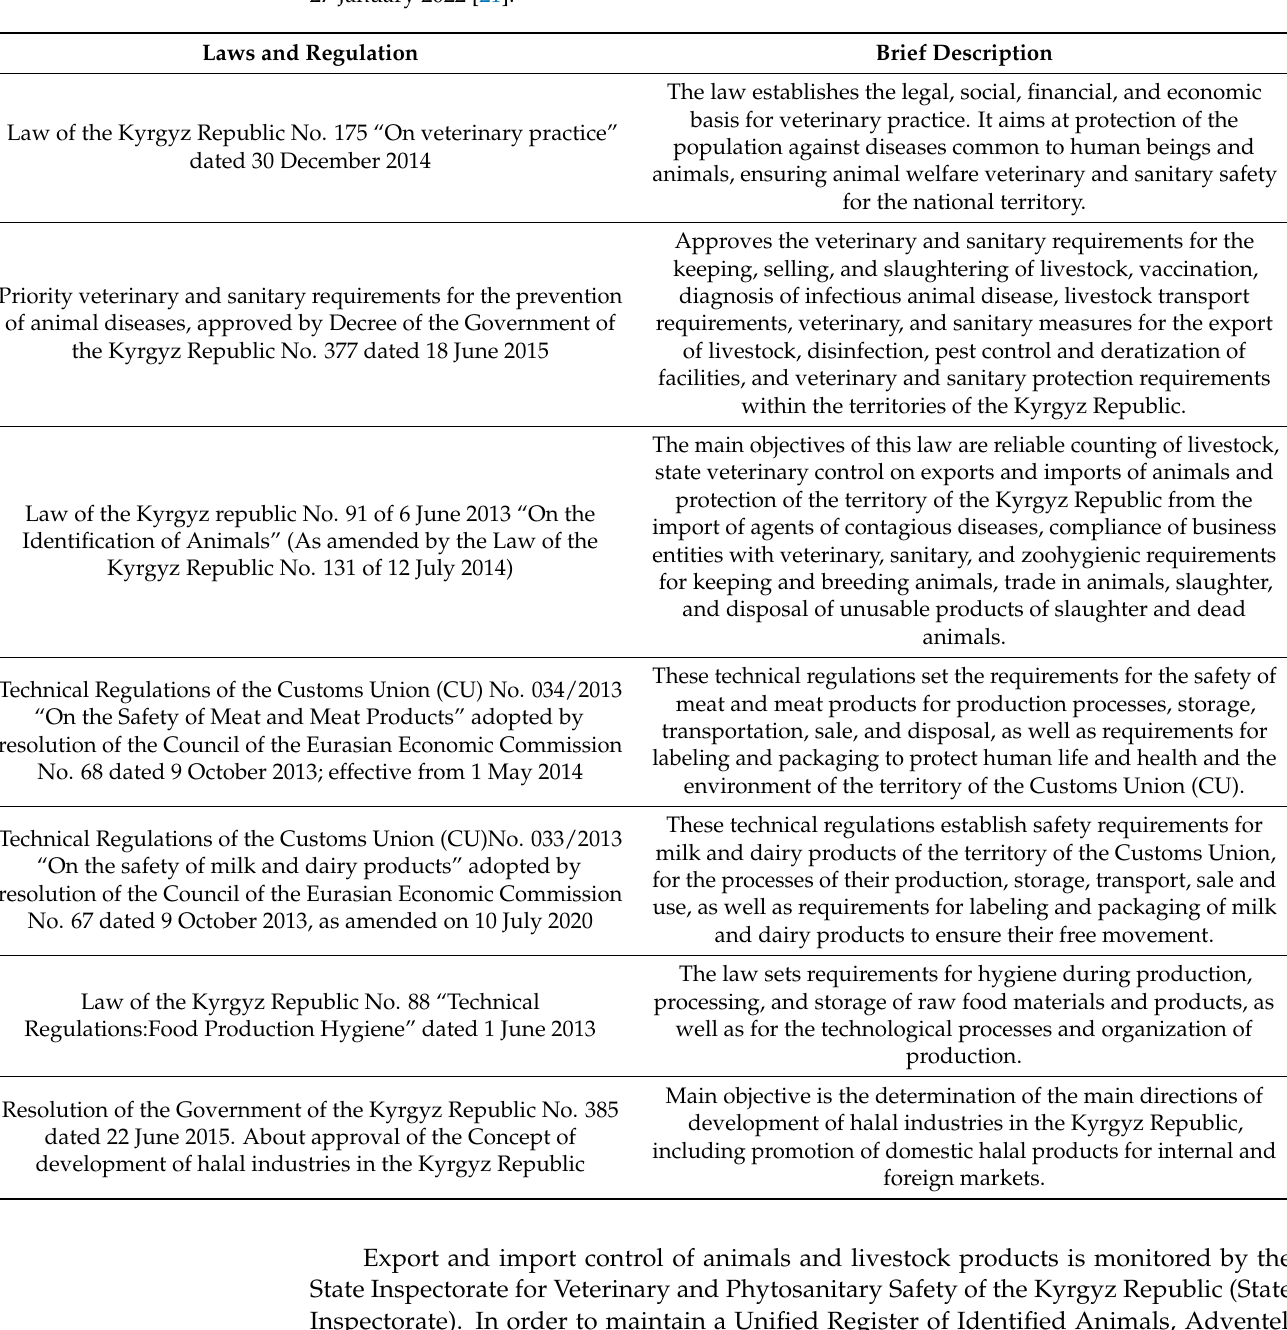
Table 4. Current laws and Regulations of the Veterinary System in the Kyrgyz Republic.